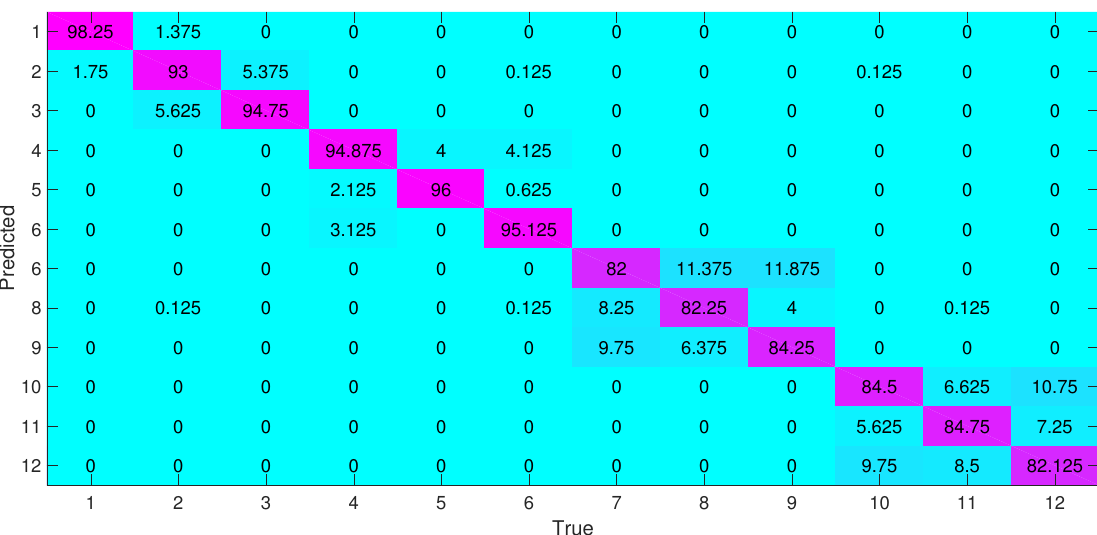
Figure 10. Confusion matrix for WSST calculated with the optimized values of Table 2 and SNR = 50 dB.